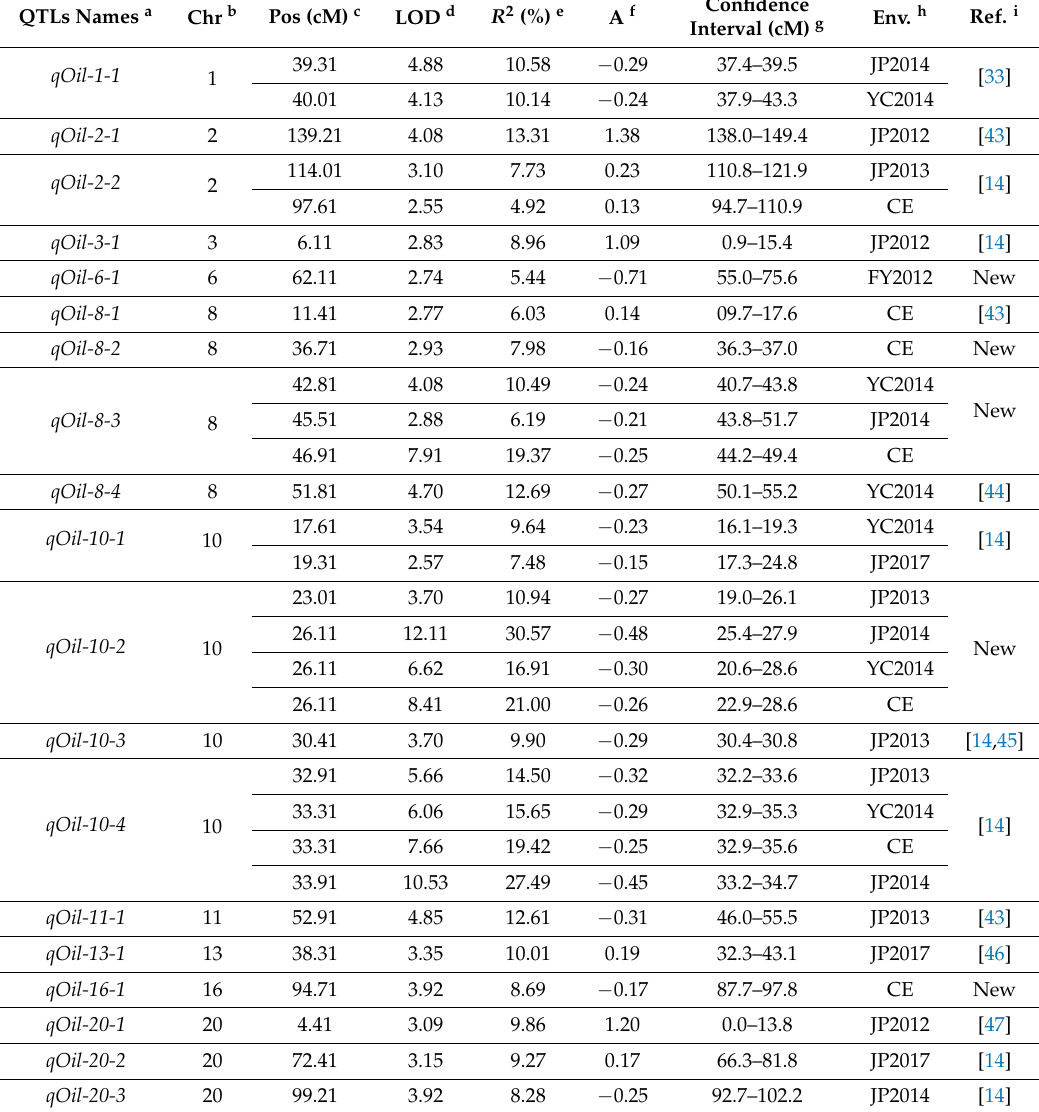
Table 2. Main-effect QTLs for seed oil content in the LM6 RIL population across the six environments and combined